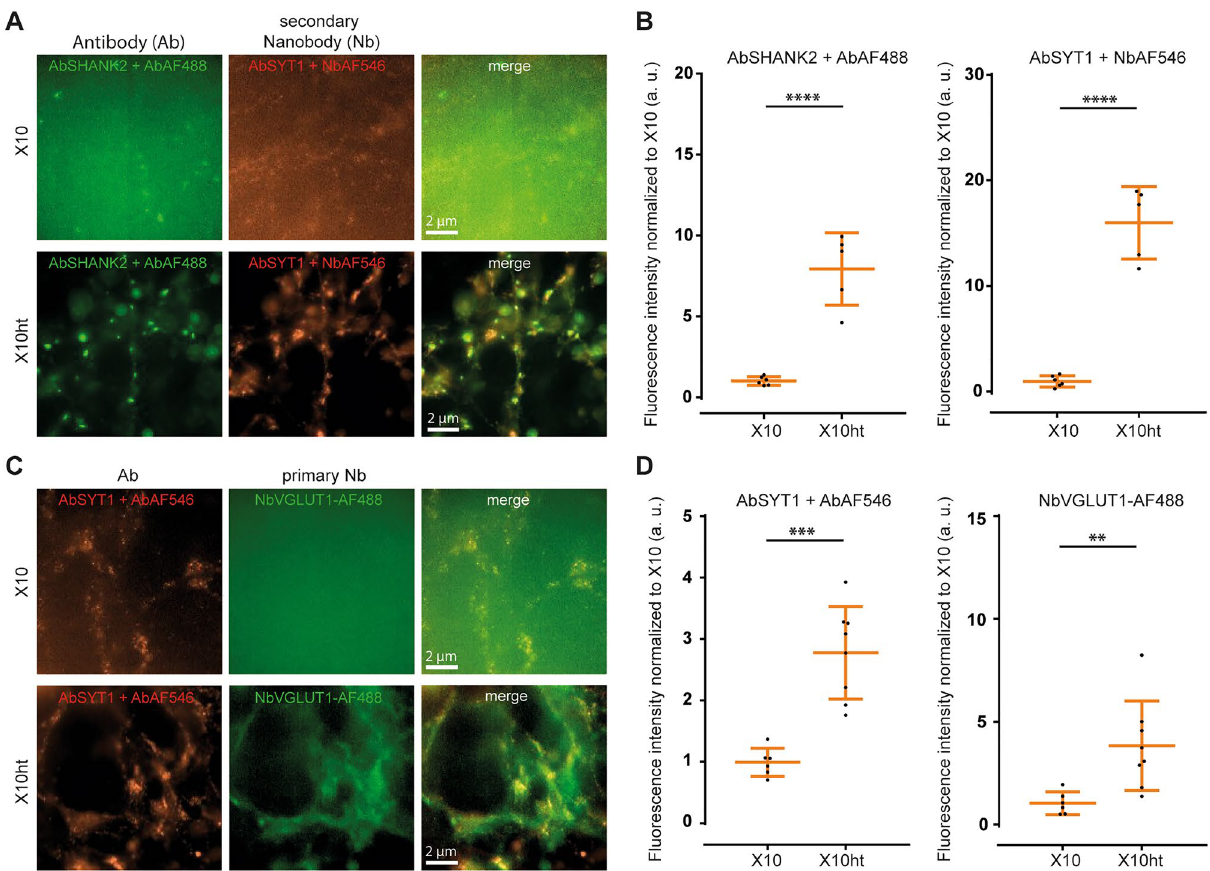
Figure 2. Applicability of nanobodies in X10ht, compared to homogenization with proteinase K (original X10 protocol). ( A ) Exemplary epifluorescence images of hippocampal cultured neurons immunostained with antibodies (Ab) for the postsynaptic protein SHANK2 and the presynaptic protein synaptotagmin1 (SYT1), revealed by secondary antibodies (AbSHANK2 + AbAF488) or secondary nanobodies (Nb) (AbSYT1 + NbAF546). ( B ) A pronounced increase in fluorescence intensity in both immunostainings is obtained when samples are autoclaved (X10ht) compared with the original X10 protocol. N = 6 images with several ROI analyzed for AbSHANK2 + AF488 X10 and AbSYT1 + NbAF546 X10, and N = 5 images with several ROI analyzed for AbSHANK2 + AF488 X10ht and AbSYT1 + NbAF546 X10ht. ( C ) Exemplary images of SYT1 antibody immunostainings, revealed by a secondary antibody (AbSYT1 + Ab AF546), in parallel with labeling for the vesicular glutamate transporter 1 (VGLUT1) with primary nanobodies coupled to AF488 (NbVGLUT1-AF488). ( D ) The quantification of the fluorescence signal revealed significantly increased intensities with X10ht. N = 6 images with several ROI analyzed for AbSYT1 + AbAF546 X10 and NbVGLUT1-AF488 X10, and 8 images with several ROI analyzed for AbSYT1 + AbAF546 X10ht and NbVGLUT1-AF488 X10ht from 2 gels. Data are presented as single data points, mean ±